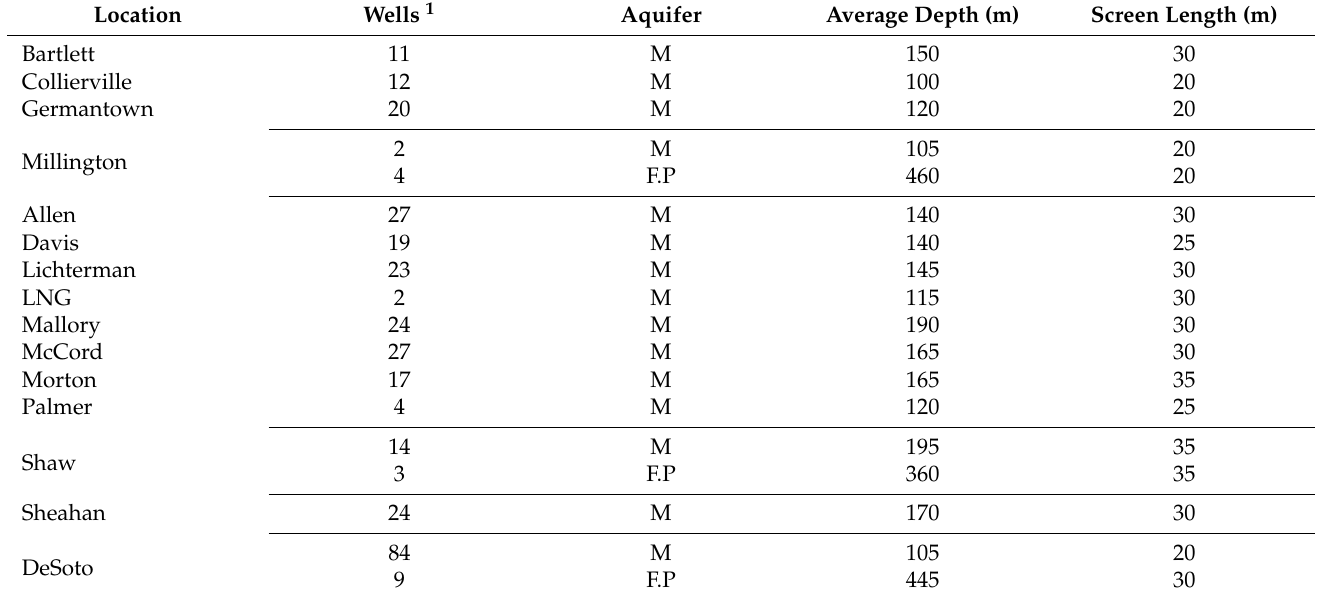
Table 2. Average depth and screen lengths for wells, listed by well field. The well fields of Millington, Shaw, and DeSoto County municipalities have wells screened in both the Memphis and Fort Pillow aquifers.